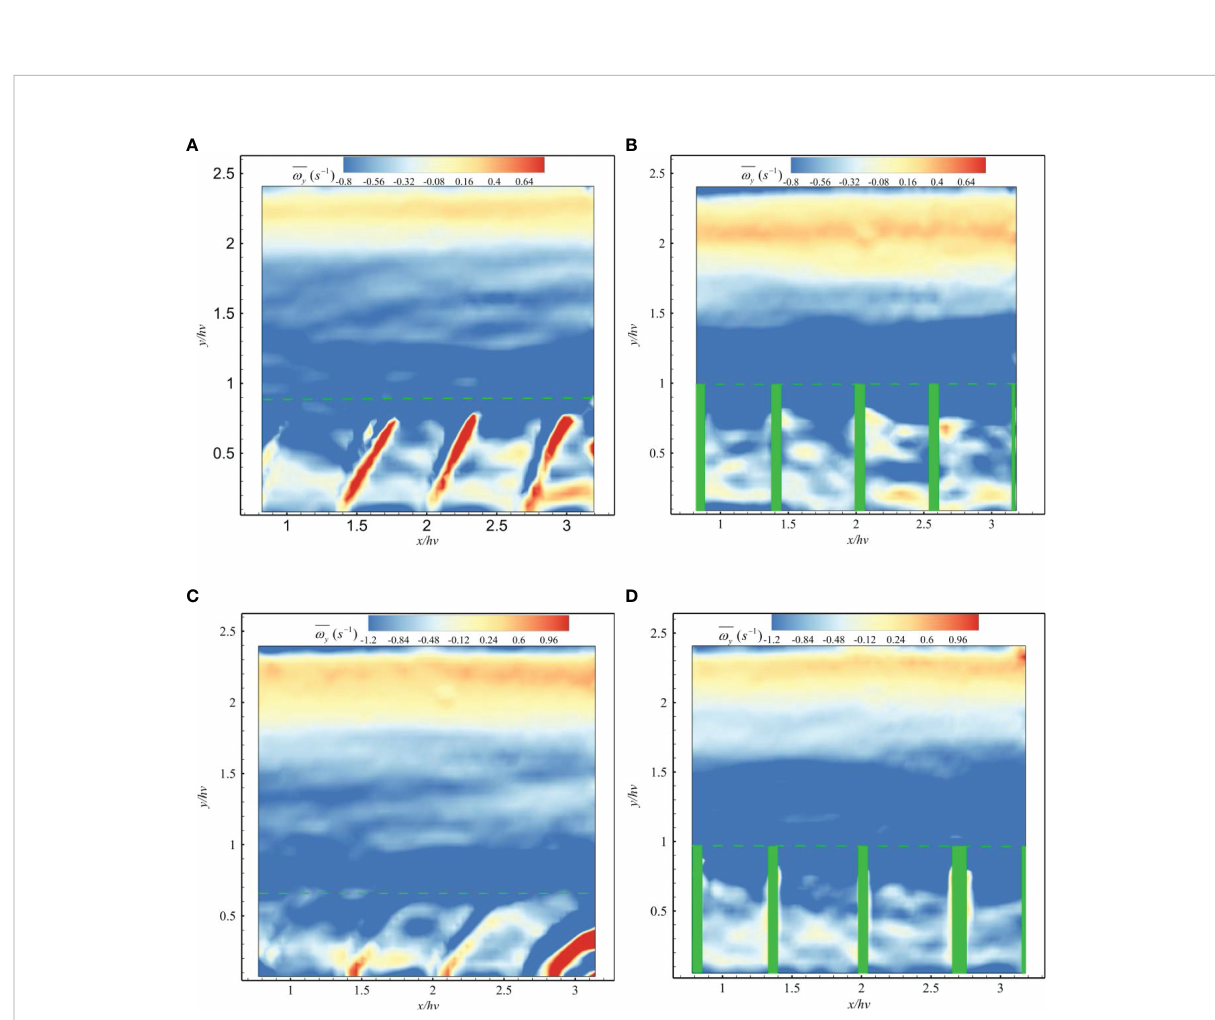
FIGURE 9 The distribution of the time-averaged vorticity w y under (A) A1-1, (B) A1-5, (C) E1-1, and (D)